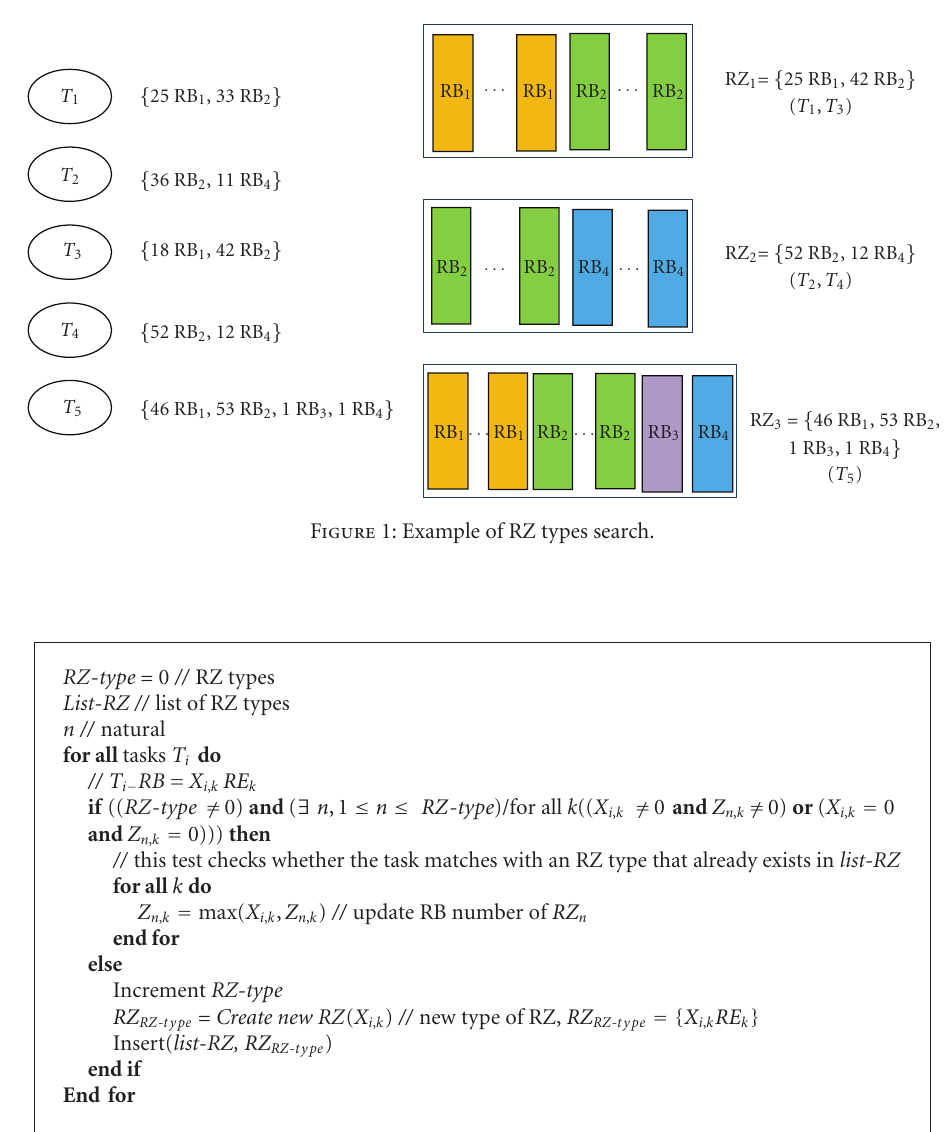
Algorithm 1: Search of RZ types.